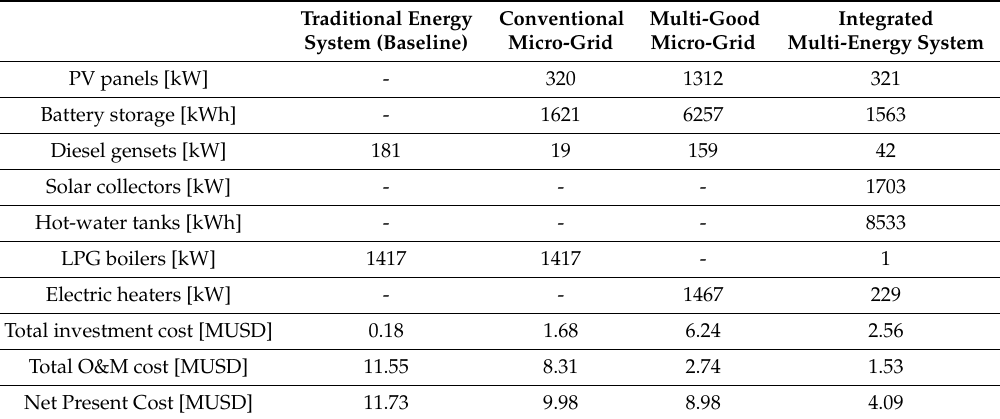
Table 3. Summary of installed nominal capacities, total investment, and operations and maintenance (O&M) costs for di ff erent energy conversion and storage technologies in the four proposed